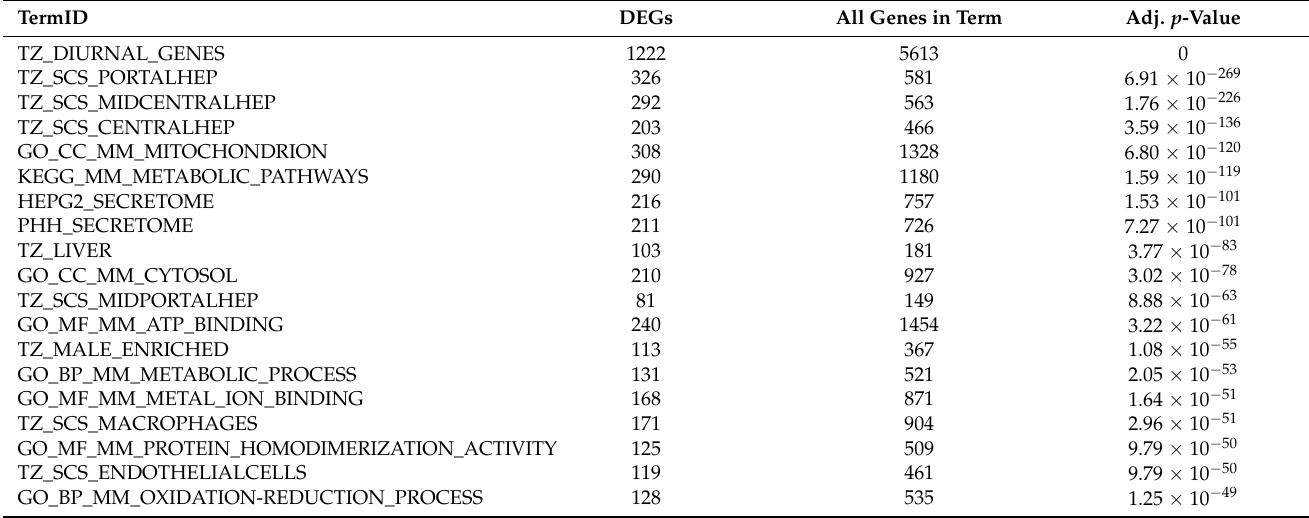
Table 1. Top 20 enriched terms of DEGs putatively co-regulated by AhR/COUP-TFII/HNF4 α in mice treated with 30 µ g/kg TCDD every 4 days for 28 days. All enriched terms are available in Supplementary File